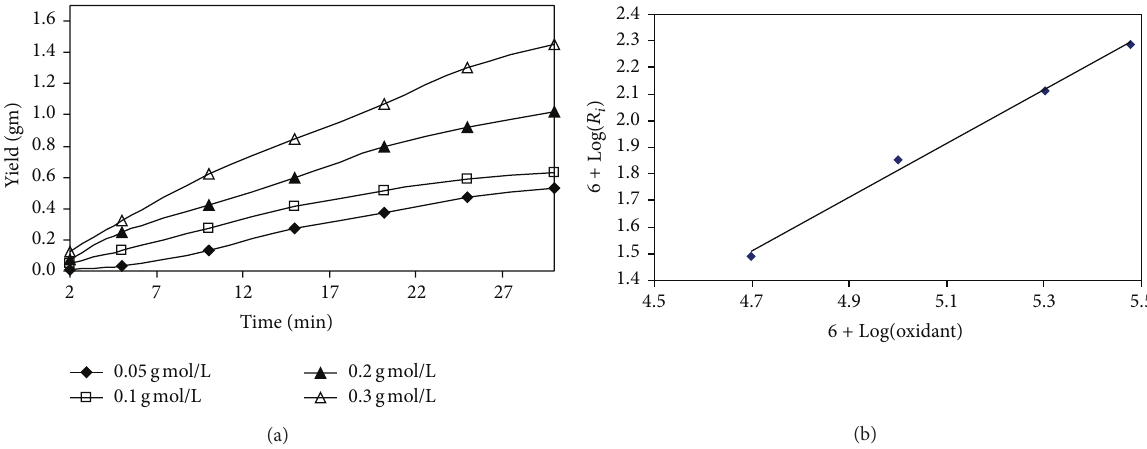
Figure 4: (a) Yield-time curve for the effect of potassium dichromate concentration on the polymerization (POPDA) at different time intervals. (b) Double logarithmic plot of the initial rate and oxidant concentration of POPDA.